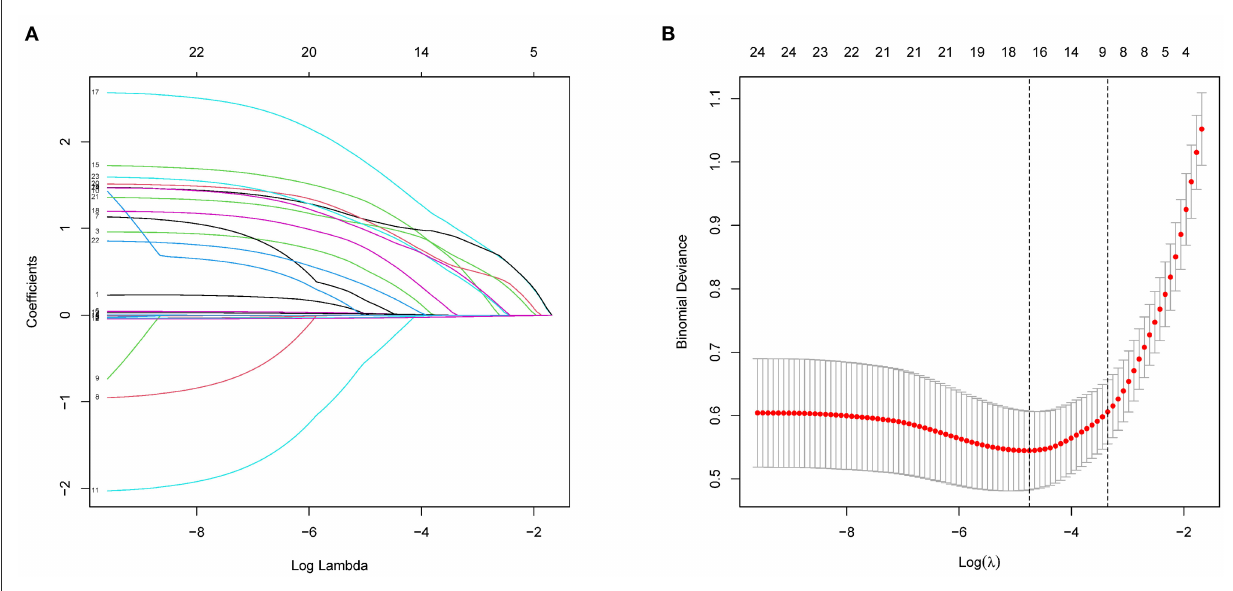
FIGURE2 Demographic and clinical feature selection using LASSO binary logistic regression model. (A) Five-fold crossover validation of the optimal parameter (lambda) selected in the LASSO model using a minimum standard. Partial probability deviation curves were plotted as compared with log (lambda). A vertical line was drawn at the best using a minimum and a minimum (1-SE) of 1SE. (B) A range of LASSO coefficients for 24 characteristics. A coefficient spectrometry was generated based on the logarithm (lambda) sequence. Using fivefold cross-validation, the vertical line was drawn